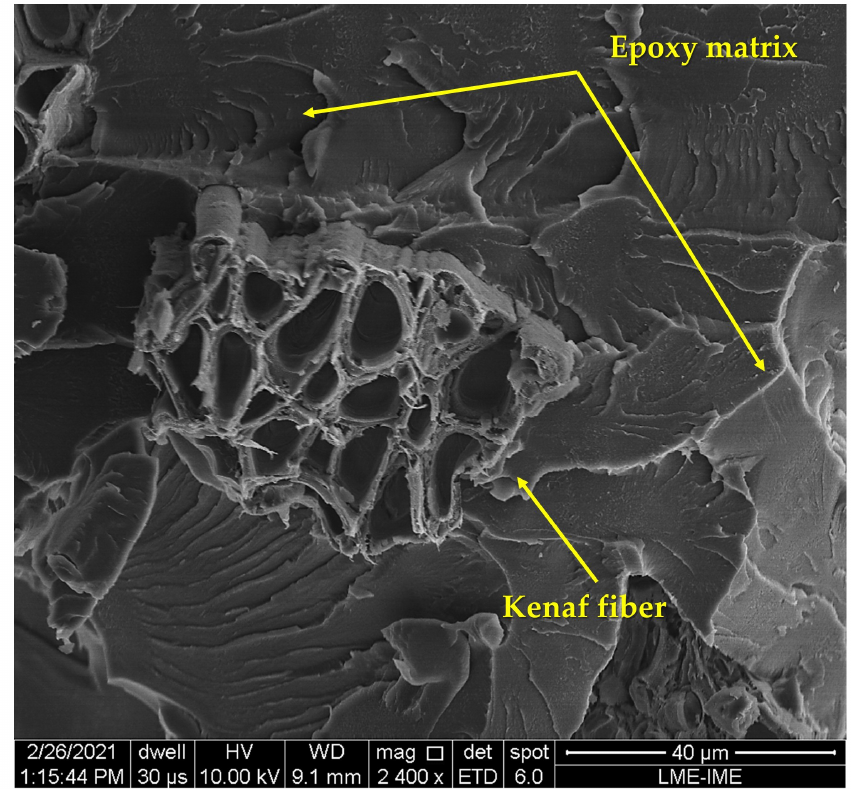
Figure 7. SEM micrograph illustrating a kenaf fiber in the epoxy